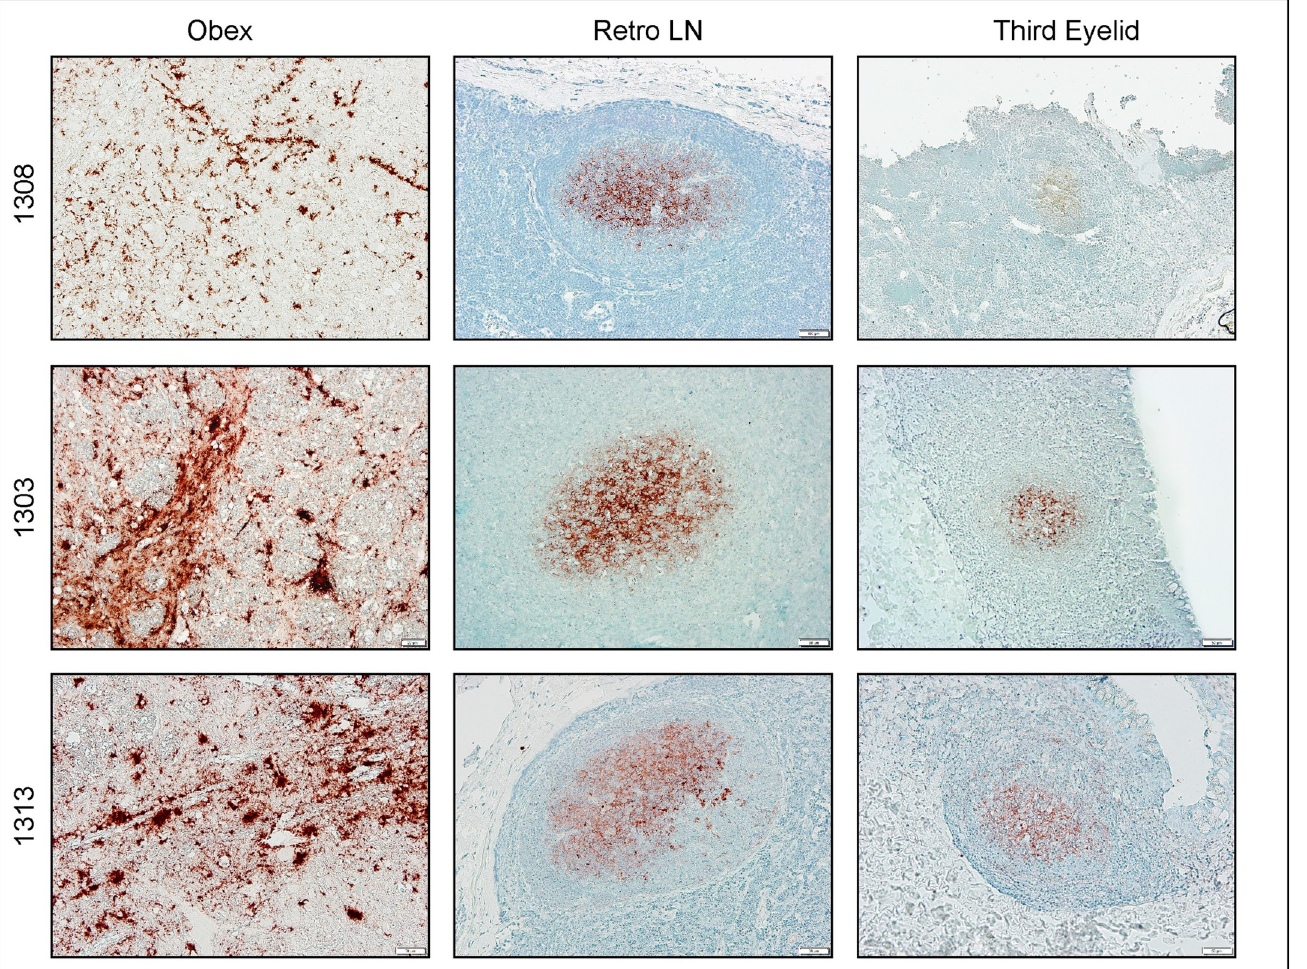
PLOS ONE | https://doi.org/10.1371/journal.pone.0221654 August 28,